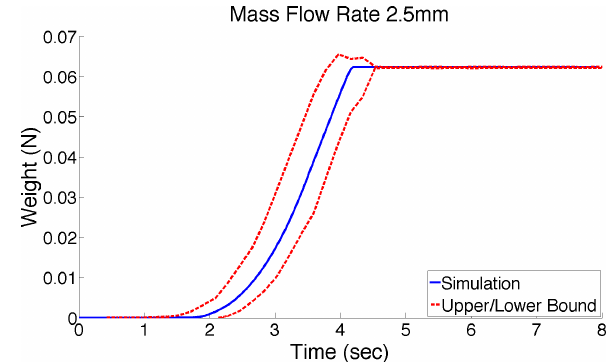
Figure 12 : Weight vs time for a gap size of 2.5 mm.